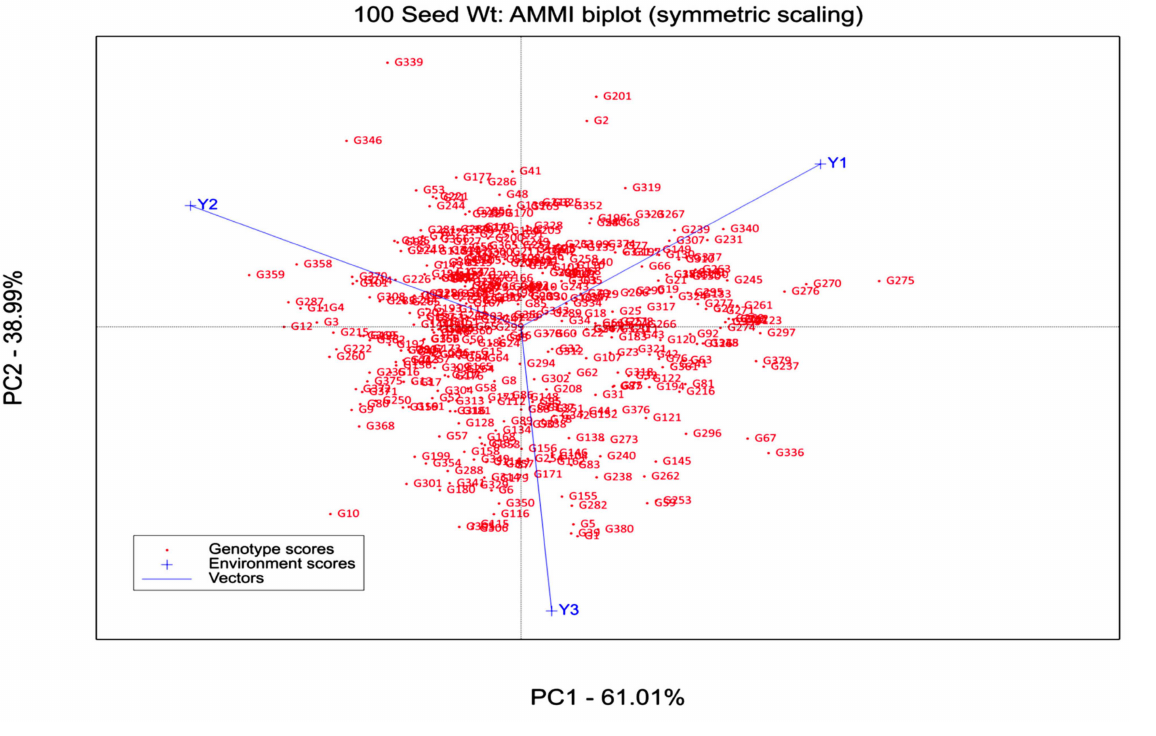
Figure 3. Seed weight—AMMI2 biplot of IPCA1 vs.